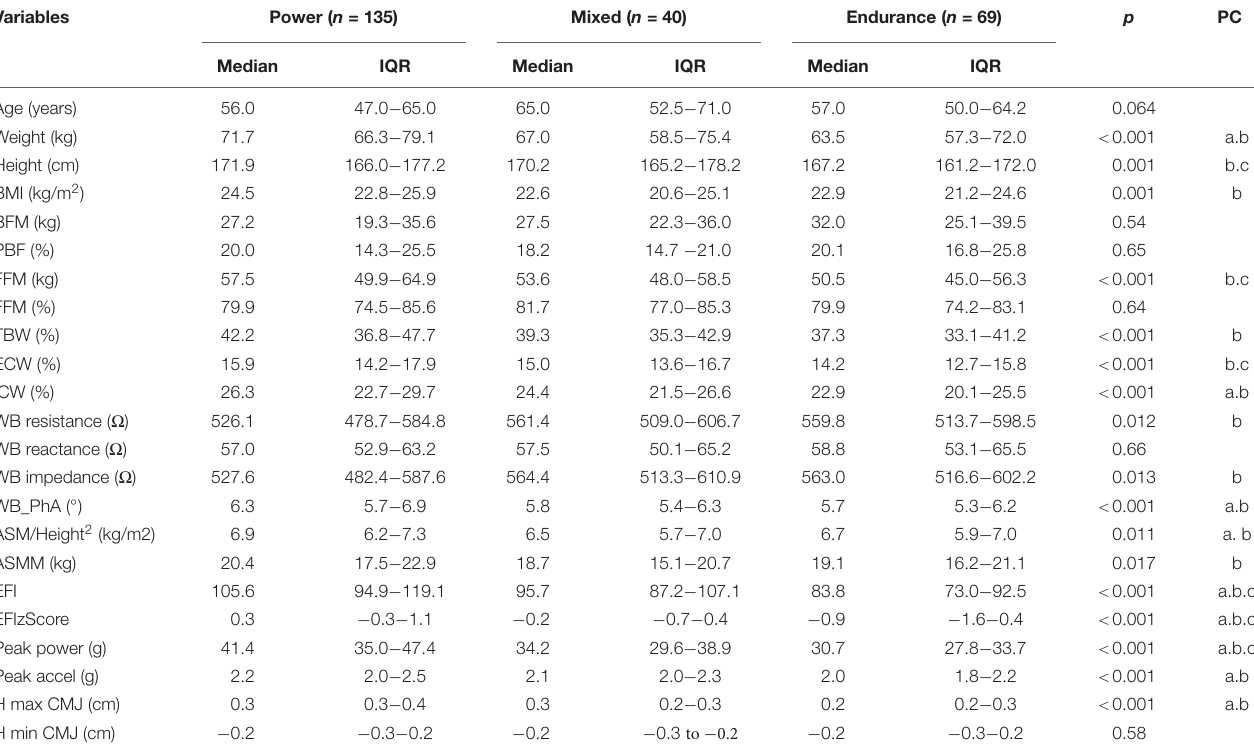
TABLE 2 | Body composition and vertical jump performance of athletes in different athletic